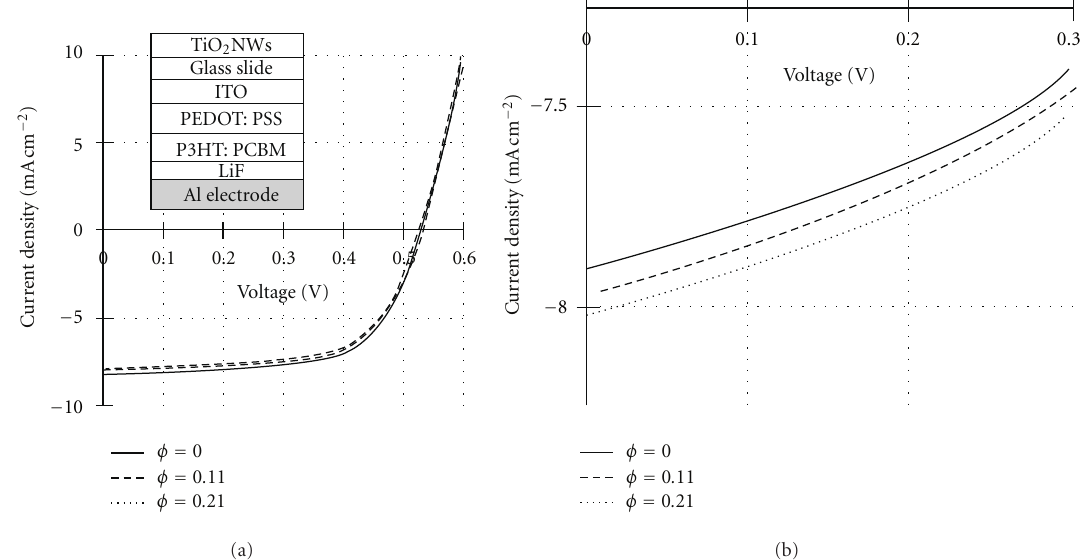
Figure 4: J - V curve obtained from BHJ organic solar cells with and without TiO 2 NW coating. (a) entire plot and (b) magnified area around J sc .